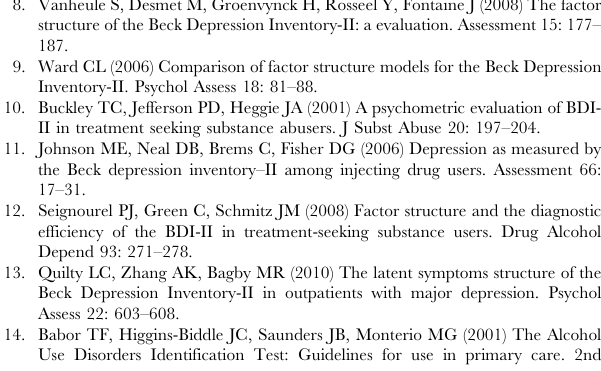
Table S1 Beck Depression Inventory-II. Means, standard deviations and inter-item correlations for patients without alcohol problems (n= 358). Table S2 Beck Depression Inventory-II. Means, standard deviations and inter-item correlations for patients with comorbid alcohol problems (n= 158).